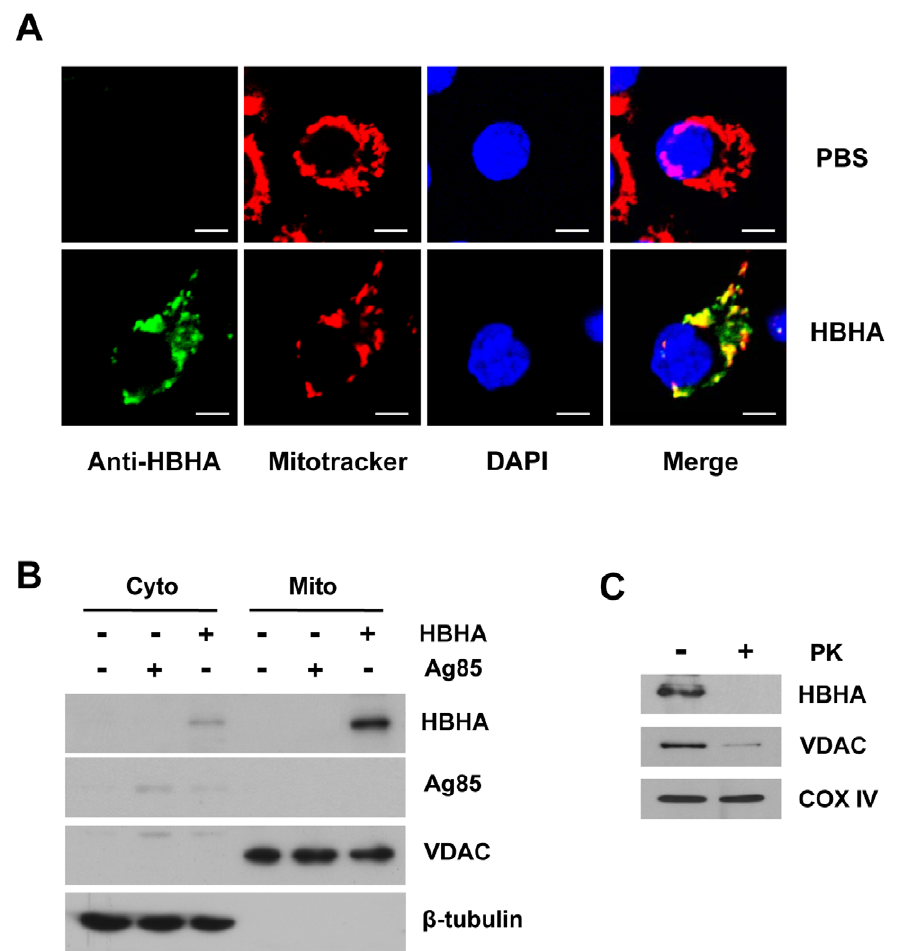
Figure 5. Subcellular localization of HBHA in macrophages. RAW 264.7 cells were exposed to HBHA (5 m g/mL), Ag85 (5 m g/mL), or an equal volume of PBS for 12 h. ( A ) Representative confocal images of HBHA (green) and Mitotracker (red) in PBS- or HBHA-treated cells. DNA was visualized with DAPI (blue). Yellow in merged images indicates co-localization. Scale bars, 5 m m. ( B ) Mitochondrial and cytosolic fractions were separated from cell lysates and examined by Western blot using specific antibodies against HBHA, VDAC, and b -tubulin. ( C ) Isolated mitochondria from cells exposed to HBHA were incubated in the presence or absence of proteinase K (200 m g/mL) for 30 min on ice. Samples were subjected to Western blot for HBHA and VDAC as described above. COX IV was used as a loading